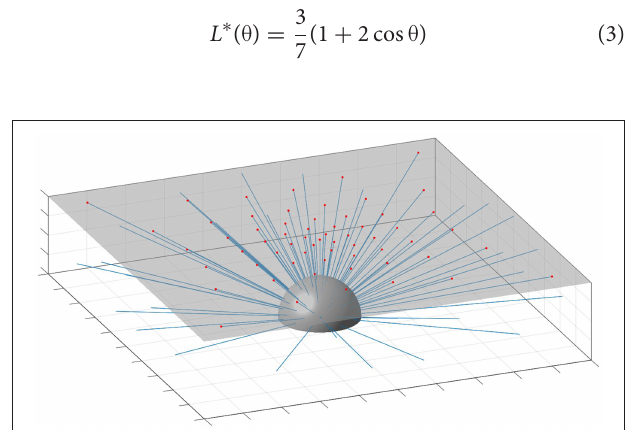
FIGURE 1 | Geometry of the light model integrator. The half sphere represents the unit Lebedev sphere with blue rays pointing in the direction of each segment. Rays are intersecting the surface (gray transparent layer) in the location of the red dots. At these locations radiance values are taken from the inhomogenous surface